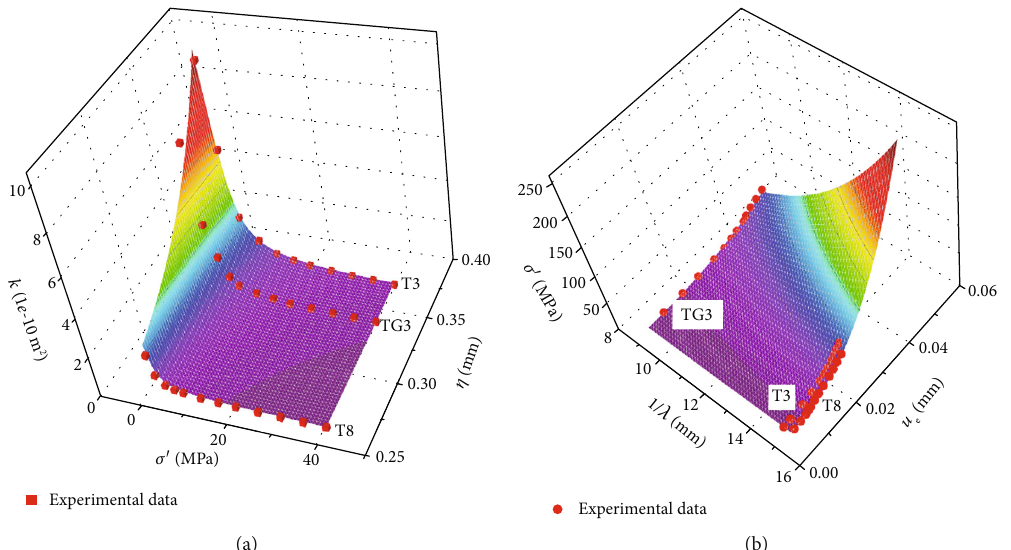
Figure 9: Demonstration of the fi tting surface of (a) permeability and (b) normal loading stress and comparison with experimental data.